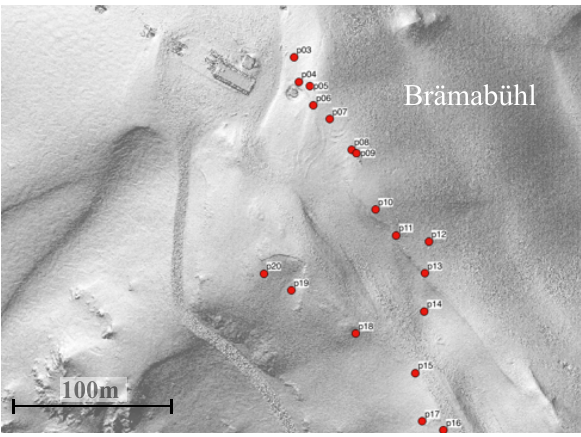
Figure 1. Test site "Brämabühl"